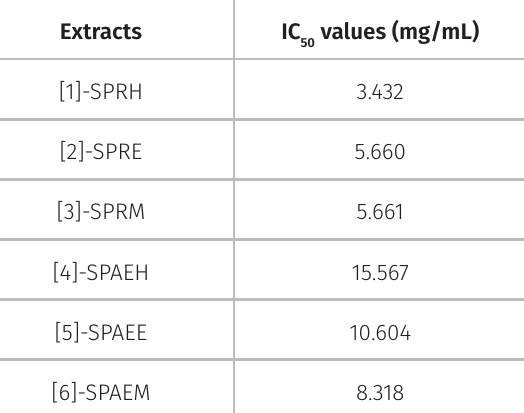
values of extracts determined by MTT